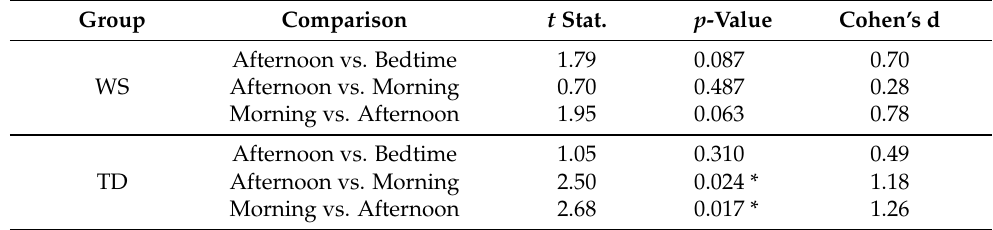
Table 6. Comparison by group of cortisol concentrations at baseline (afternoon), bedtime, and morning. Group Comparison t Stat. p -Value Cohen’s d Afternoon vs. Bedtime 1.79 0.087 WS Afternoon vs. Morning 0.70 Morning vs. Afternoon 1.95 Afternoon vs. Bedtime